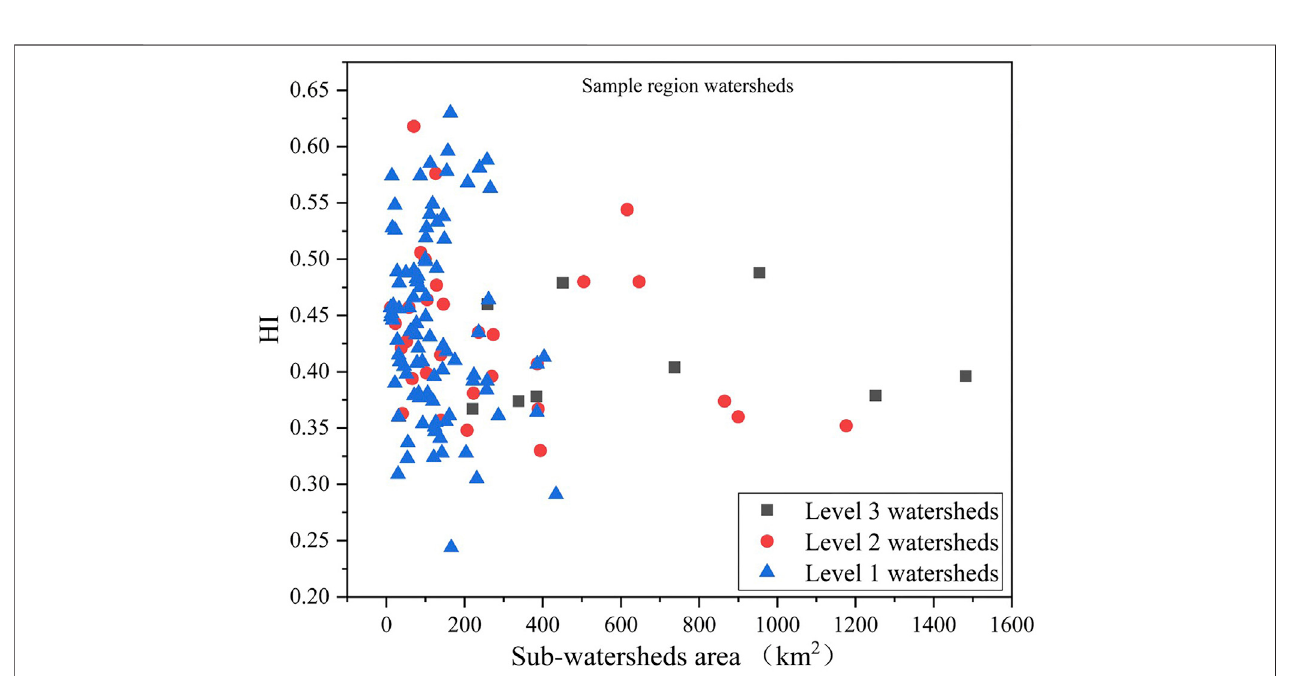
FIGURE 4 | Scatter point distribution diagram of hypsometric integral value and area of each level of sub-watersheds.